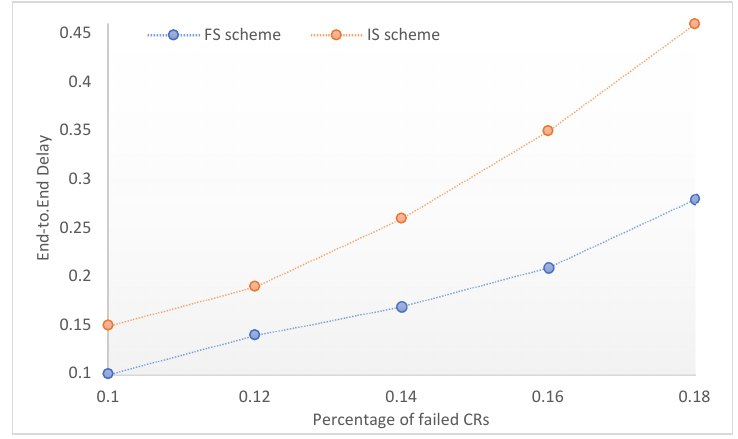
Figure 5. End-to-End delay under different percentage of failed CRs .